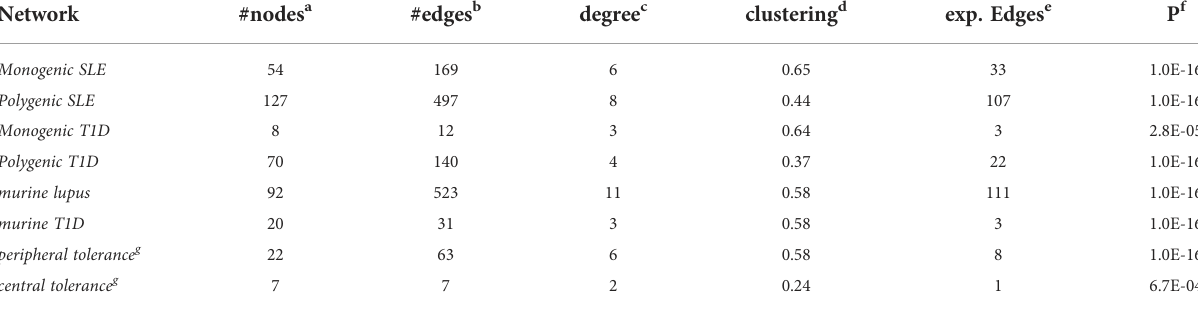
TABLE 1 Network characteristics.